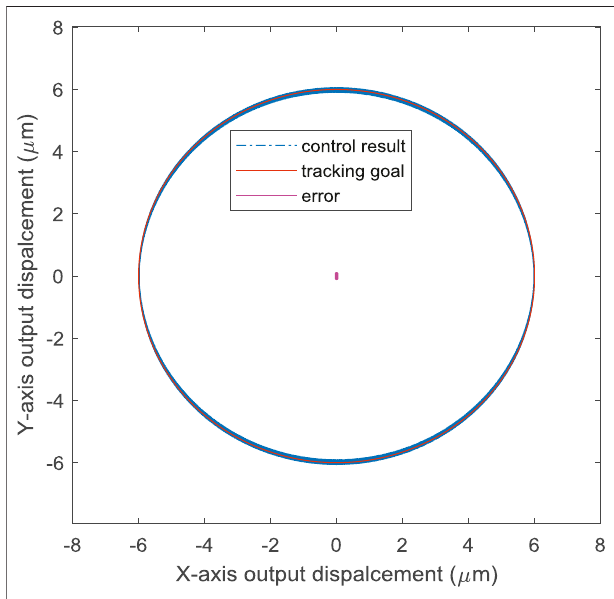
FIGURE 6 | Tracking control result of the hybrid control method with the harmonic tracking signal.